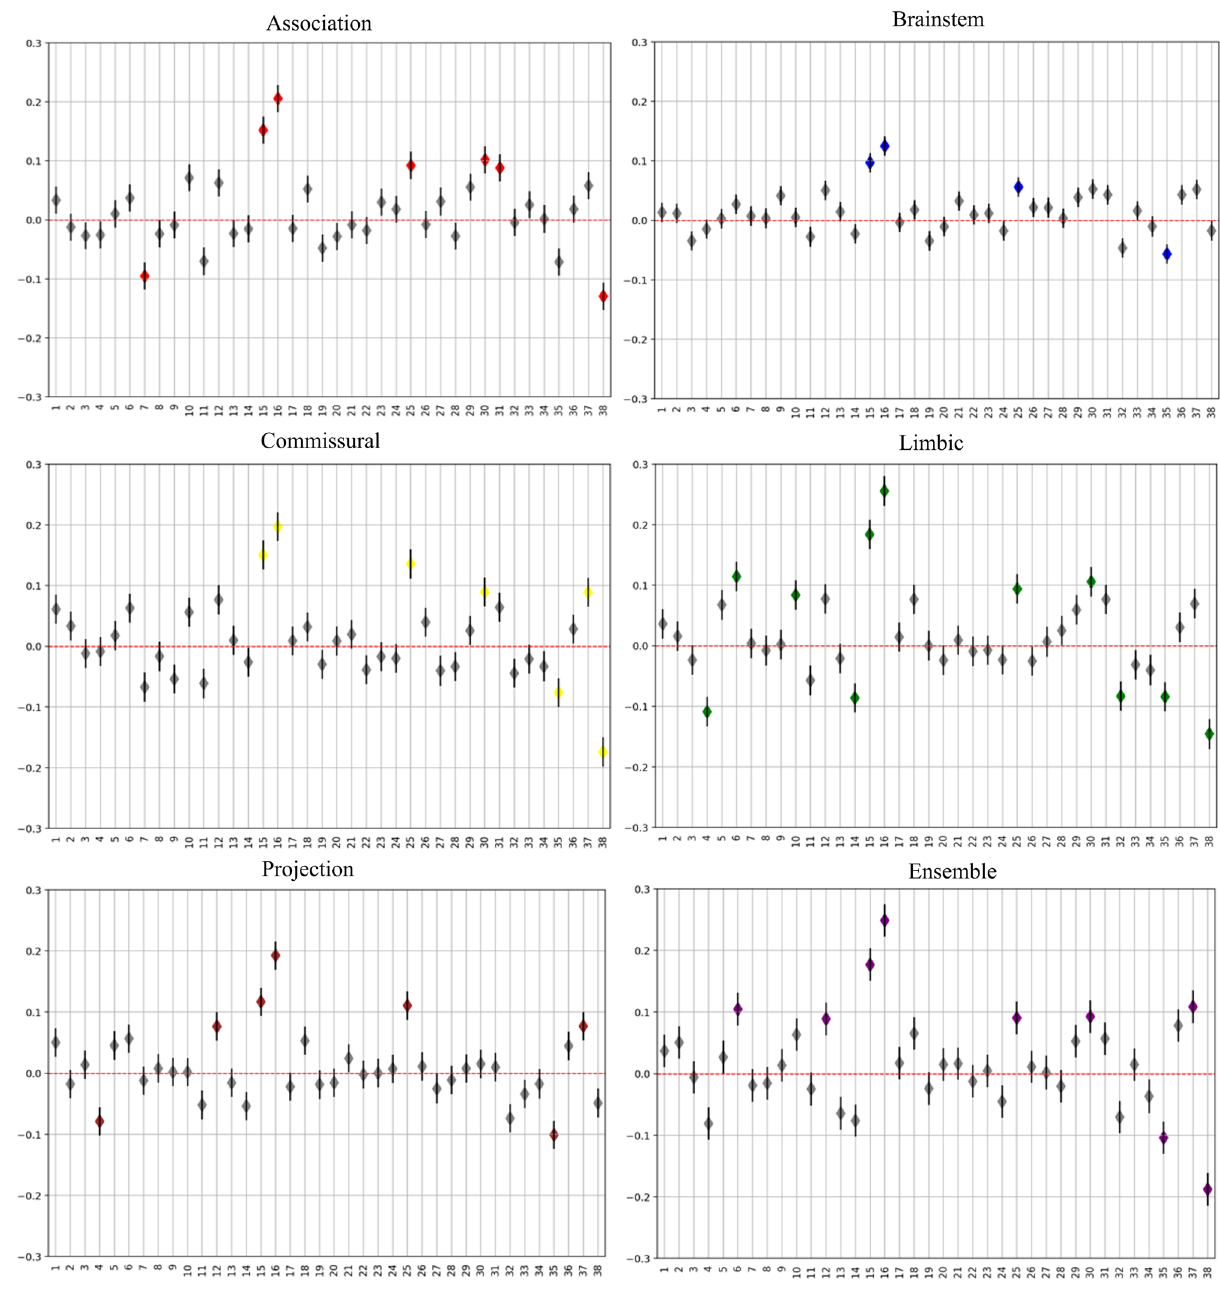
Figure 4. Association of daily lifestyle measures and brain-PAD. For each model, the numbers on the x-axis represents the order of the daily lifestyle measures summarised in the legend, while the regression coefficient (the diamond shape represents the beta coefficient) values are reported in the y-axis along with their standard error. Grey color indicates non-significant association. A unique color was assigned to each group measures(e.g physical